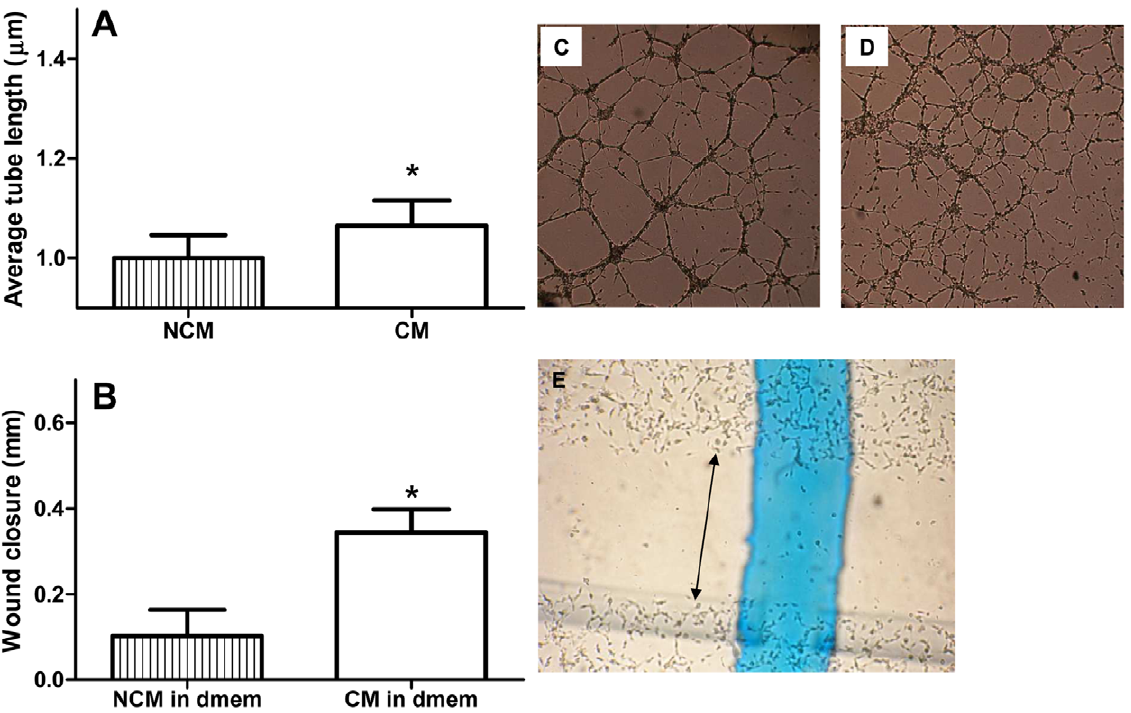
Figure 9. CM stimulates in vitro angiogenesis (A) and wound closure (B). Average tube length was increased after CM treatment compared to NCM (C + D). In a scratch wound assay, CM treatment increased wound (indicated by black arrow in E) closure compared to NCM treatment. *P , 0.05 CM vs. NCM.